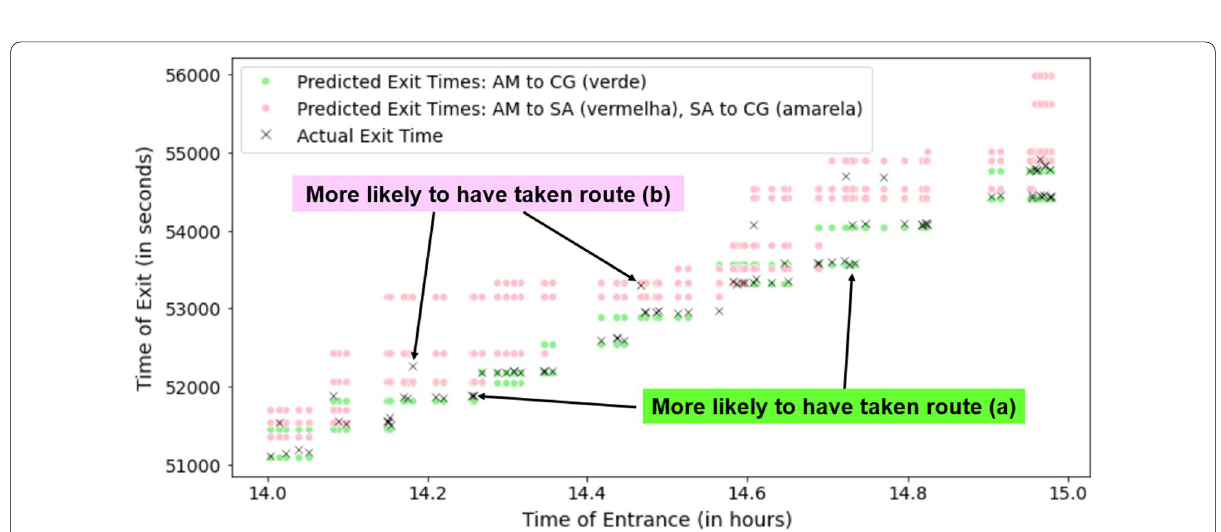
Fig. 8 Actual passenger exit times in comparison with the expected exit times for two different routes from Alameda to Campo